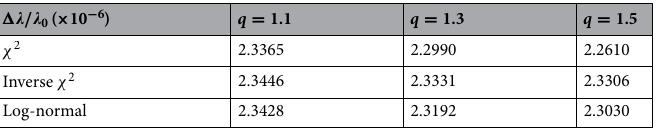
Table 1. Estimated values of � (cid:31) / (cid:31) 0 ( for different values of q